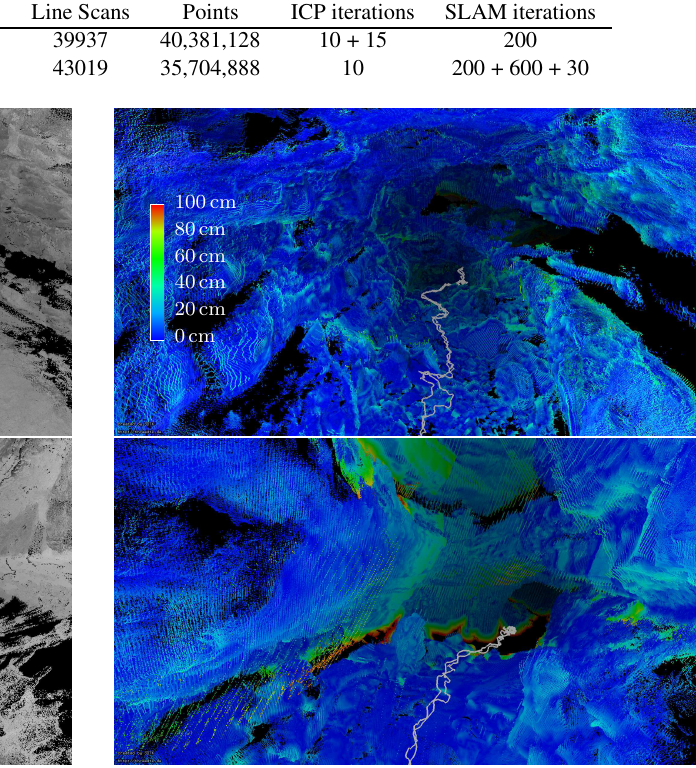
Figure 4. Reference point cloud, colored by reflectance values. Above: view near the starting point of the experiments. Below: